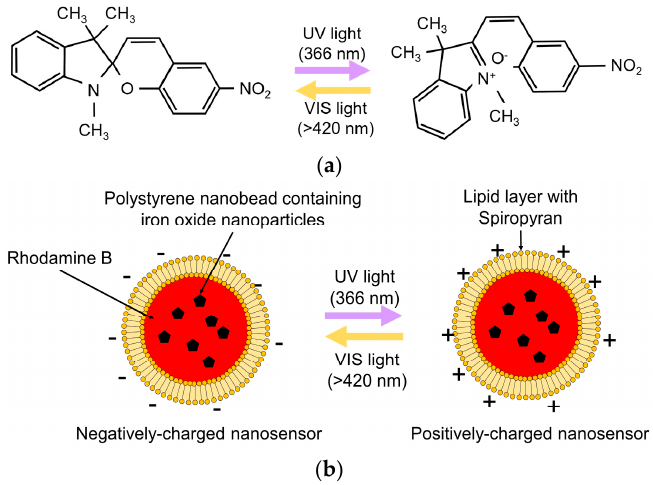
Figure 3. Schematic diagram of optical control of zeta potential. ( a ) Changes in the molecular structure of SP by photo-isomerization; ( b ) Optical control of zeta potential of the nanosensor.